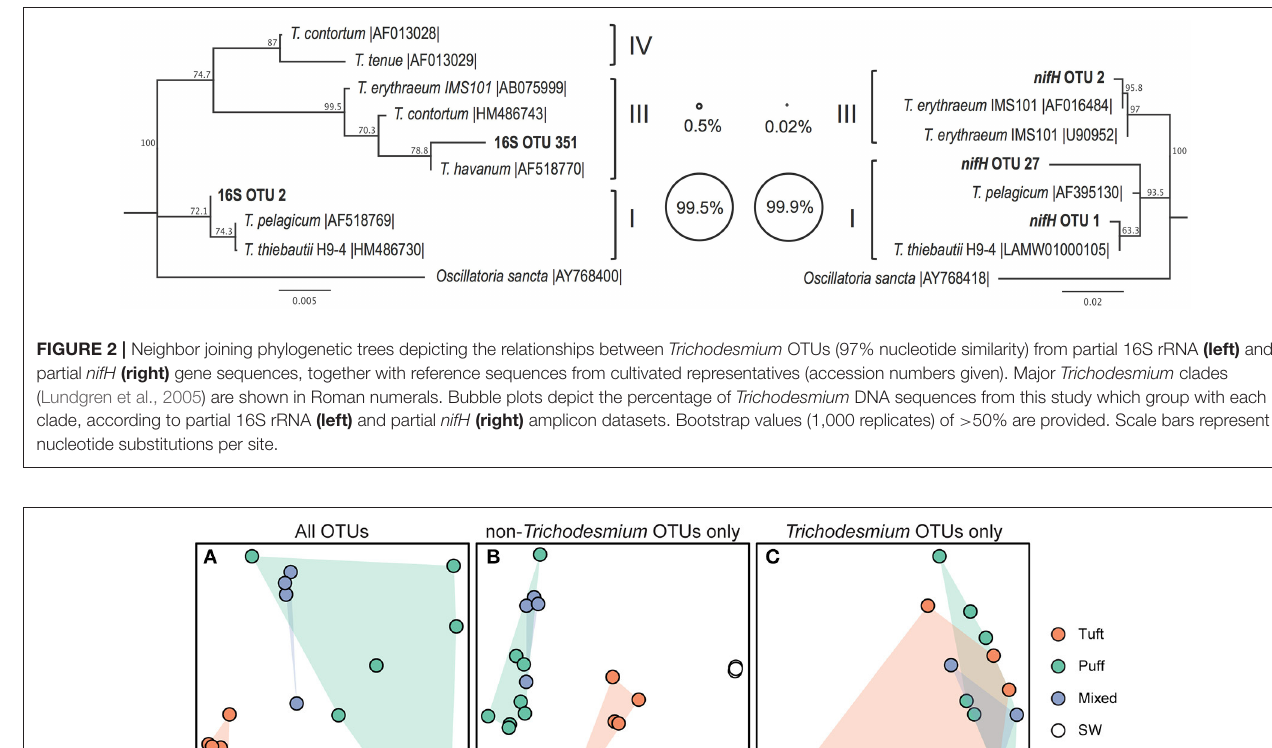
Frontiers in Microbiology |